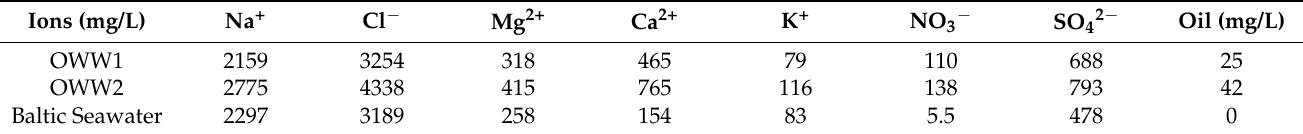
Table 1. The ion and oil concentration in the oily wastewaters (OWW1 and OWW2) and Baltic